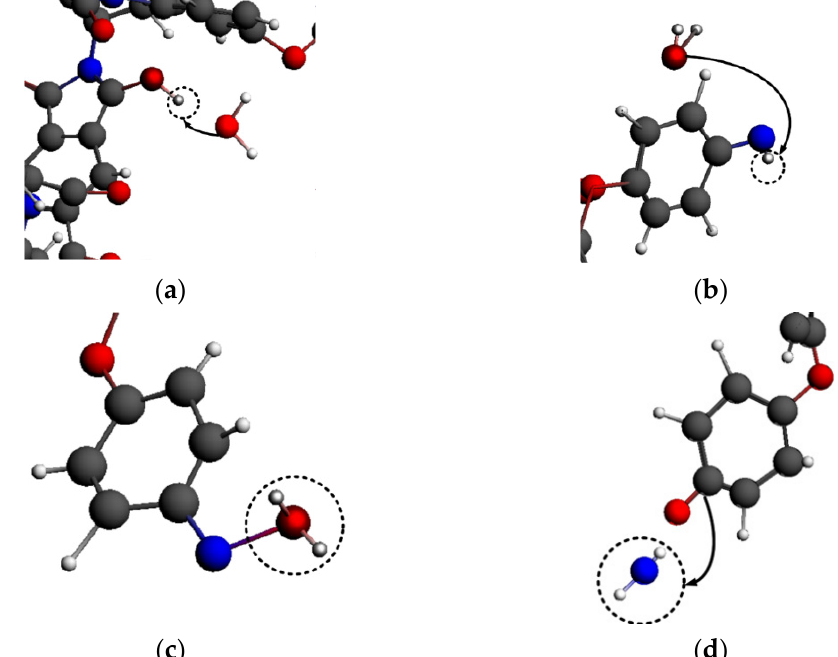
Figure 16. Functional mechanism of · H 3 O ( a ) hydrogen abstraction process of oxygen; ( b ) hydrogen abstraction process of nitrogen; ( c ) adsorption process of · H 3 O; ( d ) adsorption process of · H 3 O.